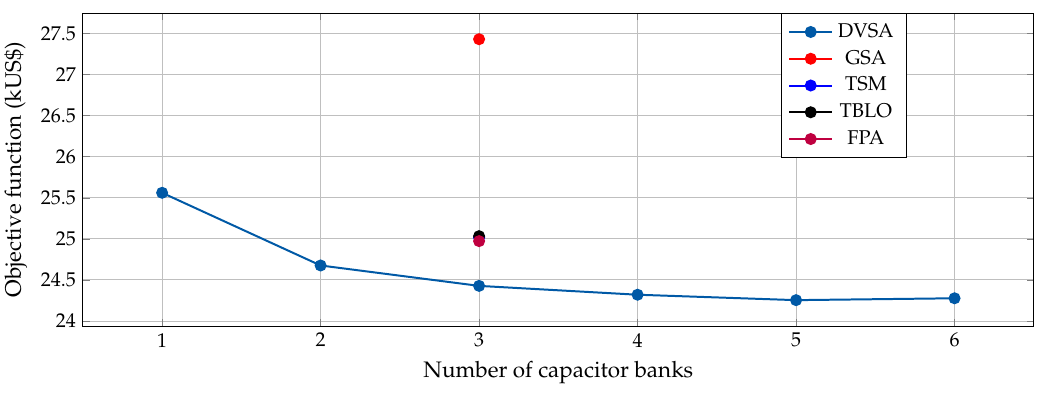
Figure 8. Impact of the number of capacitor banks in the final operation costs.